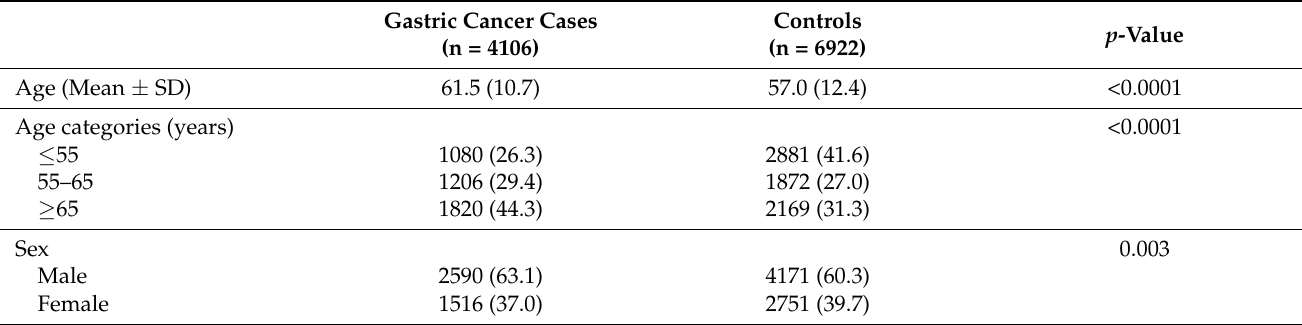
Table 1. Baseline Characteristics of Gastric Cancer Cases and Controls in the Stomach Cancer Pooling (StoP)